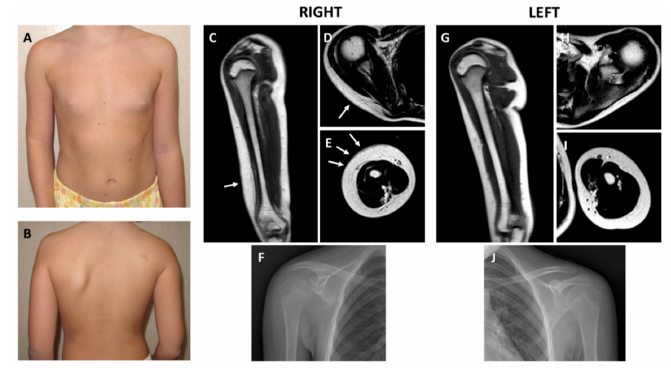
Figure 1. Clinical and radiologic features. ( A ) Front view showing limitation of the extension of the right elbow with accentuation of the cutaneous articular fold. ( B ) Back view demonstrating hypoplasia of the right scapula; note a small caf é -au-lait spot in the upper scapular region. Radiological findings of the right upper limb. ( C ) Thickening of the dermis of the lateral side of the arm at Magnetic Resonance Imaging (MRI) coronal view (arrow). ( D ) Thickened dermis at the scapular level (arrow). ( E ) Thickened dermis surrounding the arm muscles at axial view (arrows). ( F ) Plain radiograph documenting hypoplasia of the inferior part of the right scapula. Radiological findings of the left upper limb. Comparison with similar MRI sections of the a ff ected (right) side demonstrated normal representation of the dermis at coronal ( G ), and upper ( H ) and lower ( I ) axial views. Muscles are underdeveloped in the right arm. ( J ) Normal left scapula at standard